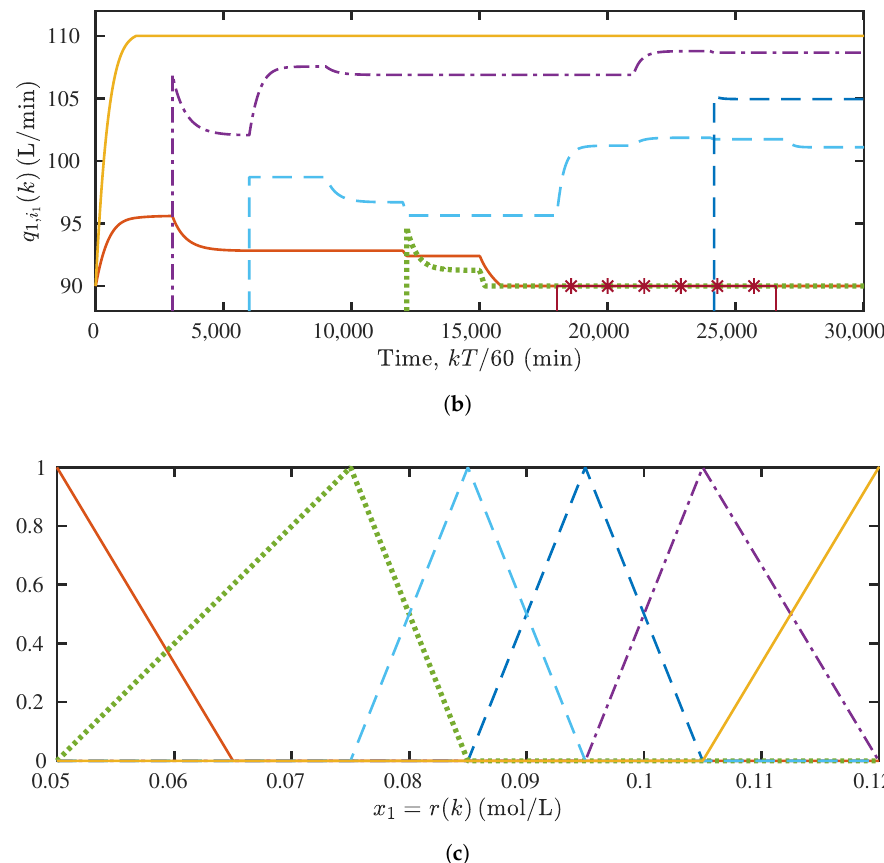
Figure 5. Evolution of the antecedent and consequent parameters of x 1 = r ( t ) . ( a ) Evolution of the antecedent parameters of x 1 = r ( t ) . ( b ) Evolution of the consequent parameters of x 1 = r ( t ) . ( c ) Final membership functions of x 1 = r ( t ) .